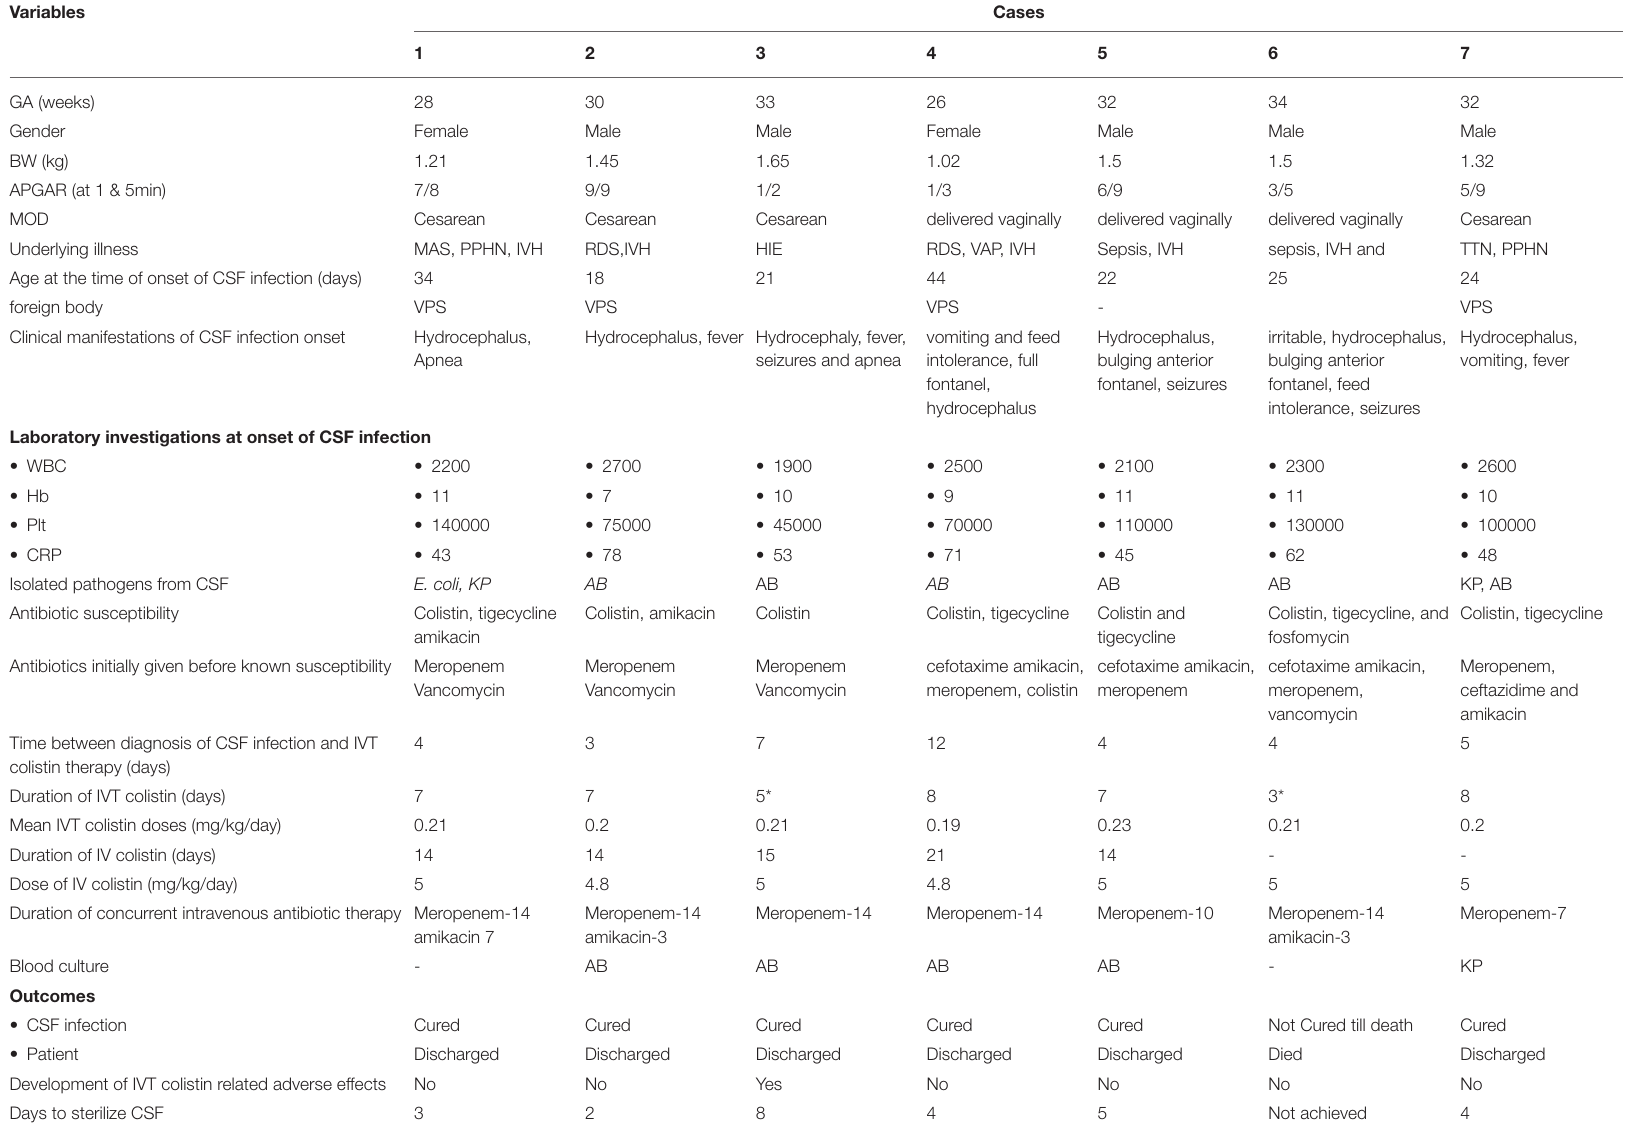
TABLE 1 | Neonatal clinical characteristics and treatment outcome.